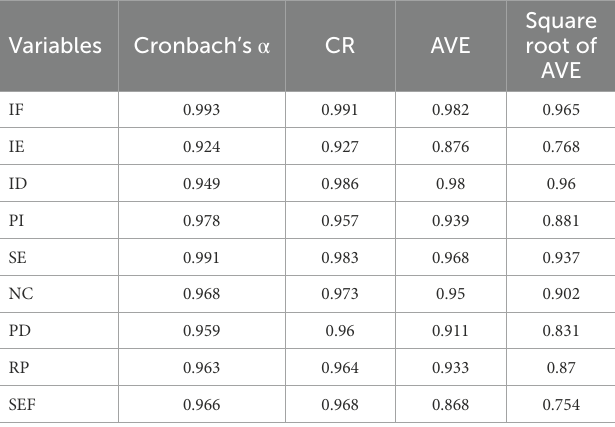
TABLE 10 Results of reliability and validity tests.